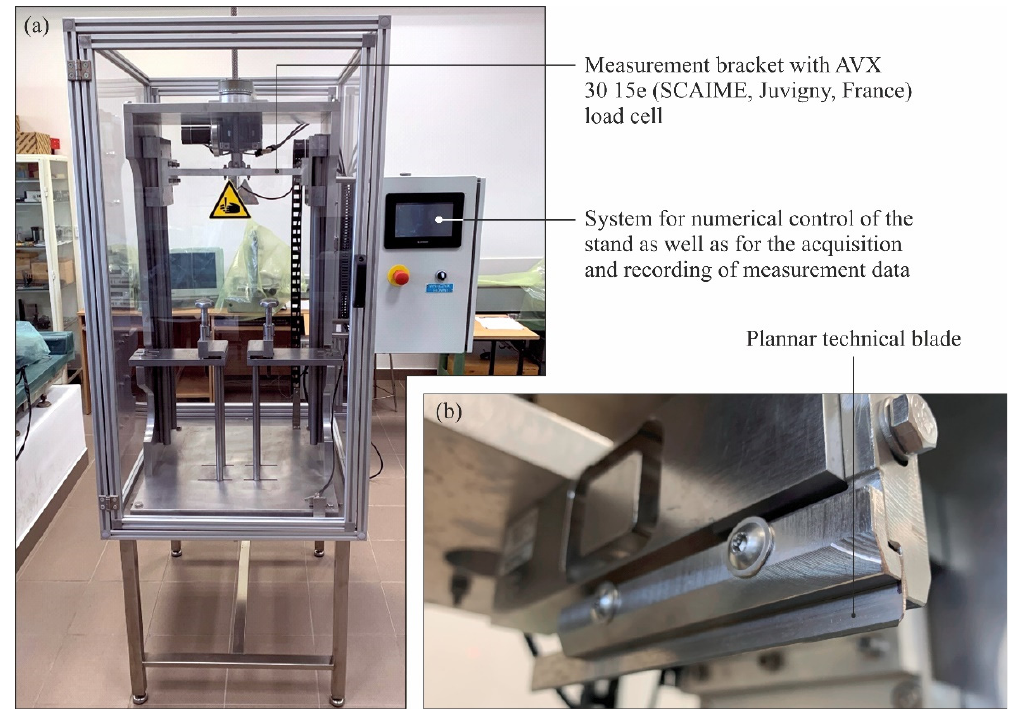
Figure 4. General view ( a ) and working space ( b ) of the special station for measuring the cutting force of planar technical blades.